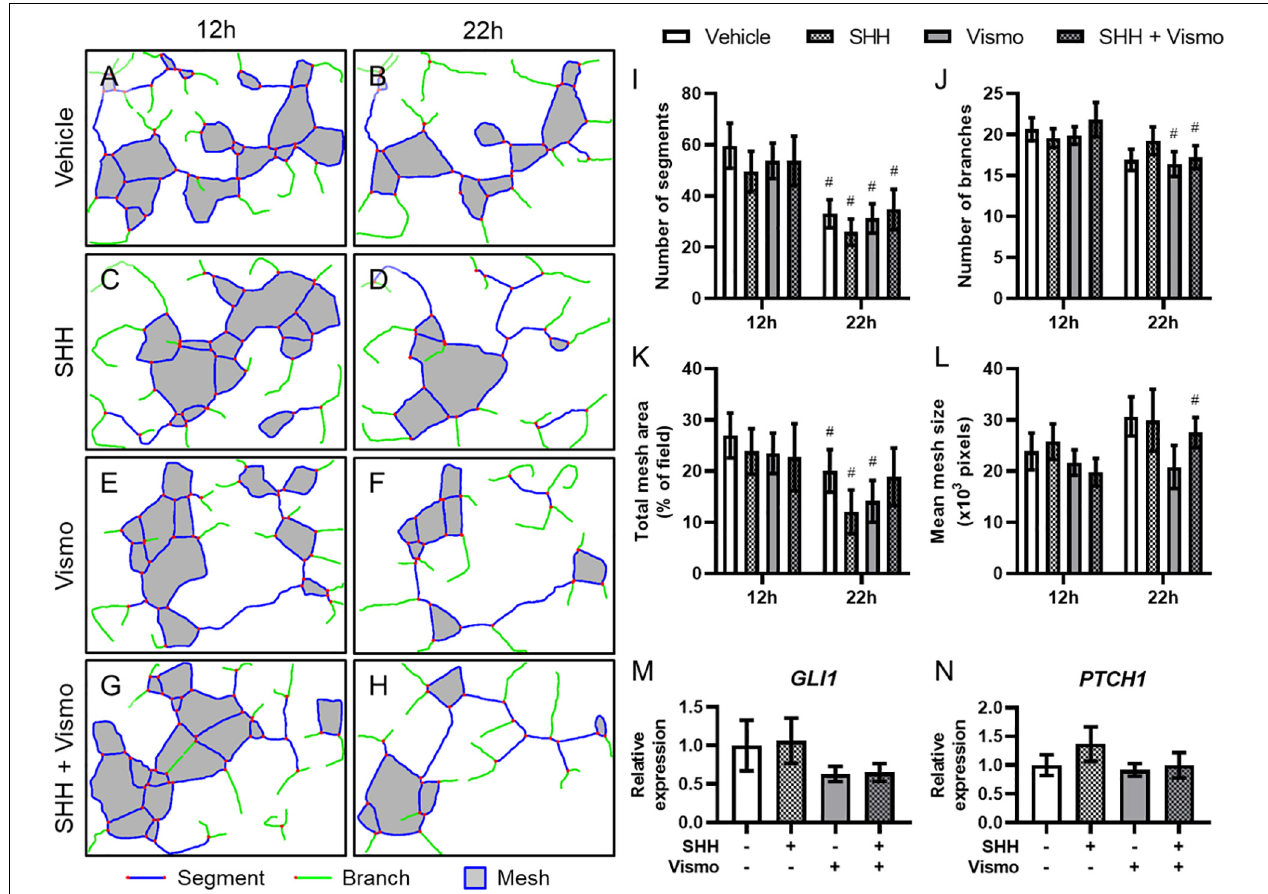
FIGURE 3 | Shh pathway perturbation in endothelial cells does not affect cord formation or downstream Shh pathway targets. (A–H) Cord network schematics of HUVECs ± 0.4 µ g/ml SHH ligand ± 200 nM vismodegib (vismo) plated on Matrigel were generated from images taken at 12 and 22 h. Blue lines are segments, green lines are branches, red dots are junctions, and filled gray areas are meshes. Images are representative of 12 biological replicates per treatment group. (I–L) Number of segments, number of branches, total mesh area, and mean mesh size as measured by the Angiogenesis plugin for ImageJ are shown for the indicated groups at 12 and 22 h. # p < 0.05 of the indicated treatment group compared to the same group at 12 h. (M,N) Canonical Shh pathway targets GLI1 and PTCH1 were assayed for gene expression by qPCR in HUVEC cords treated with SHH and/or vismodegib and harvested at 12 h. Five biological replicates were harvested for gene